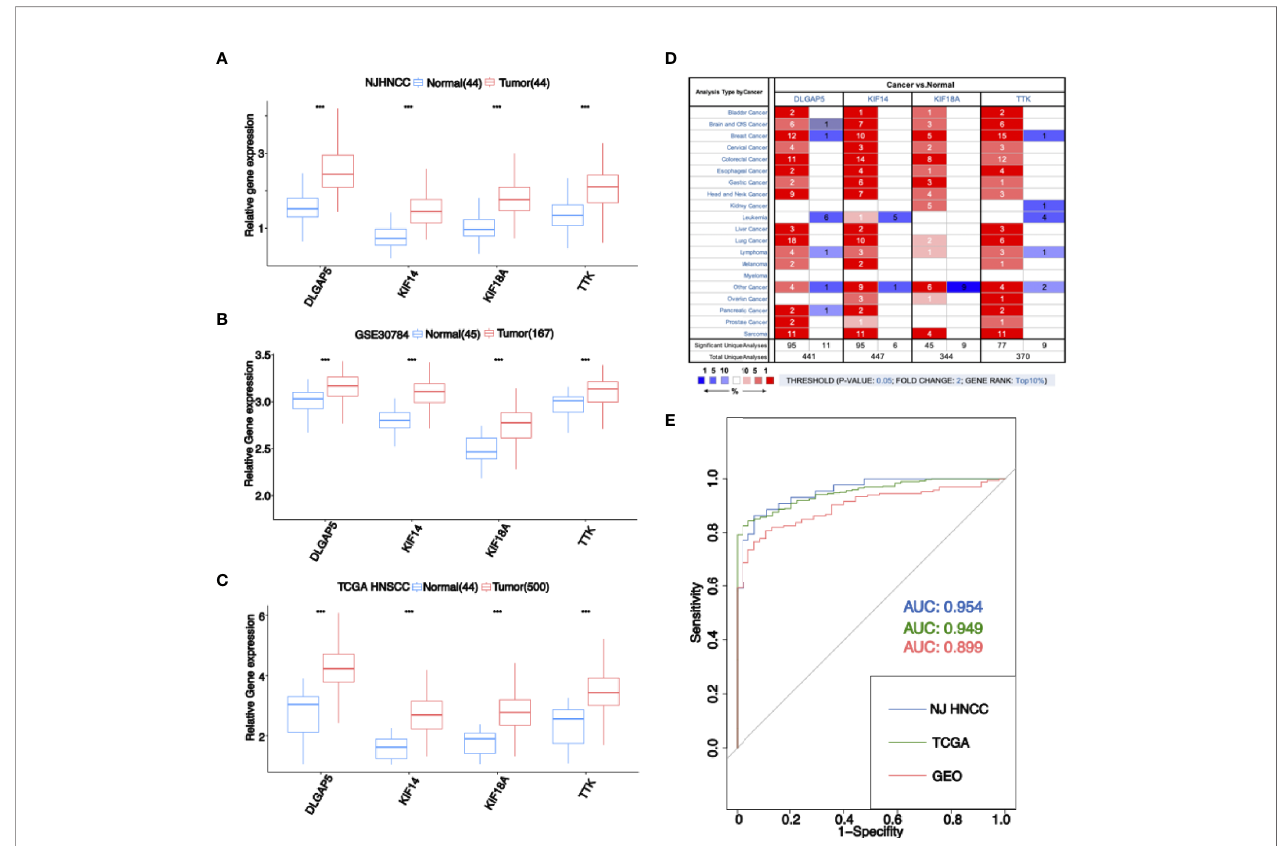
FIGURE 3 | (A) Expression of four stemness-related genes in RNA-seq data of NJHNCC. The expression of four stemness-related genes was higher in HNSCC. “ *** ” represents P < 0.001. (B) Expression of four stemness-related genes in GEO dataset. The expression of four stemness-related genes was higher in HNSCC. “ *** ” represents P < 0.001. (C) Expression of four stemness-related genes in TCGA HNSCC dataset. The expression of four stemness-related genes was higher in HNSCC. “ *** ” represents P < 0.001. (D) Expression of four stemness-related genes in Oncomine database. The number in the square is the number of researches meeting the threshold. The color of the square represents the gene rank. Red indicates high expression in tumor samples and blue indicates high expression in normal samples. (E) ROC analysis for diagnostic risk score. Blue indicates the result of NJHNCC. Green indicates the result of TCGA. Red indicates the result of